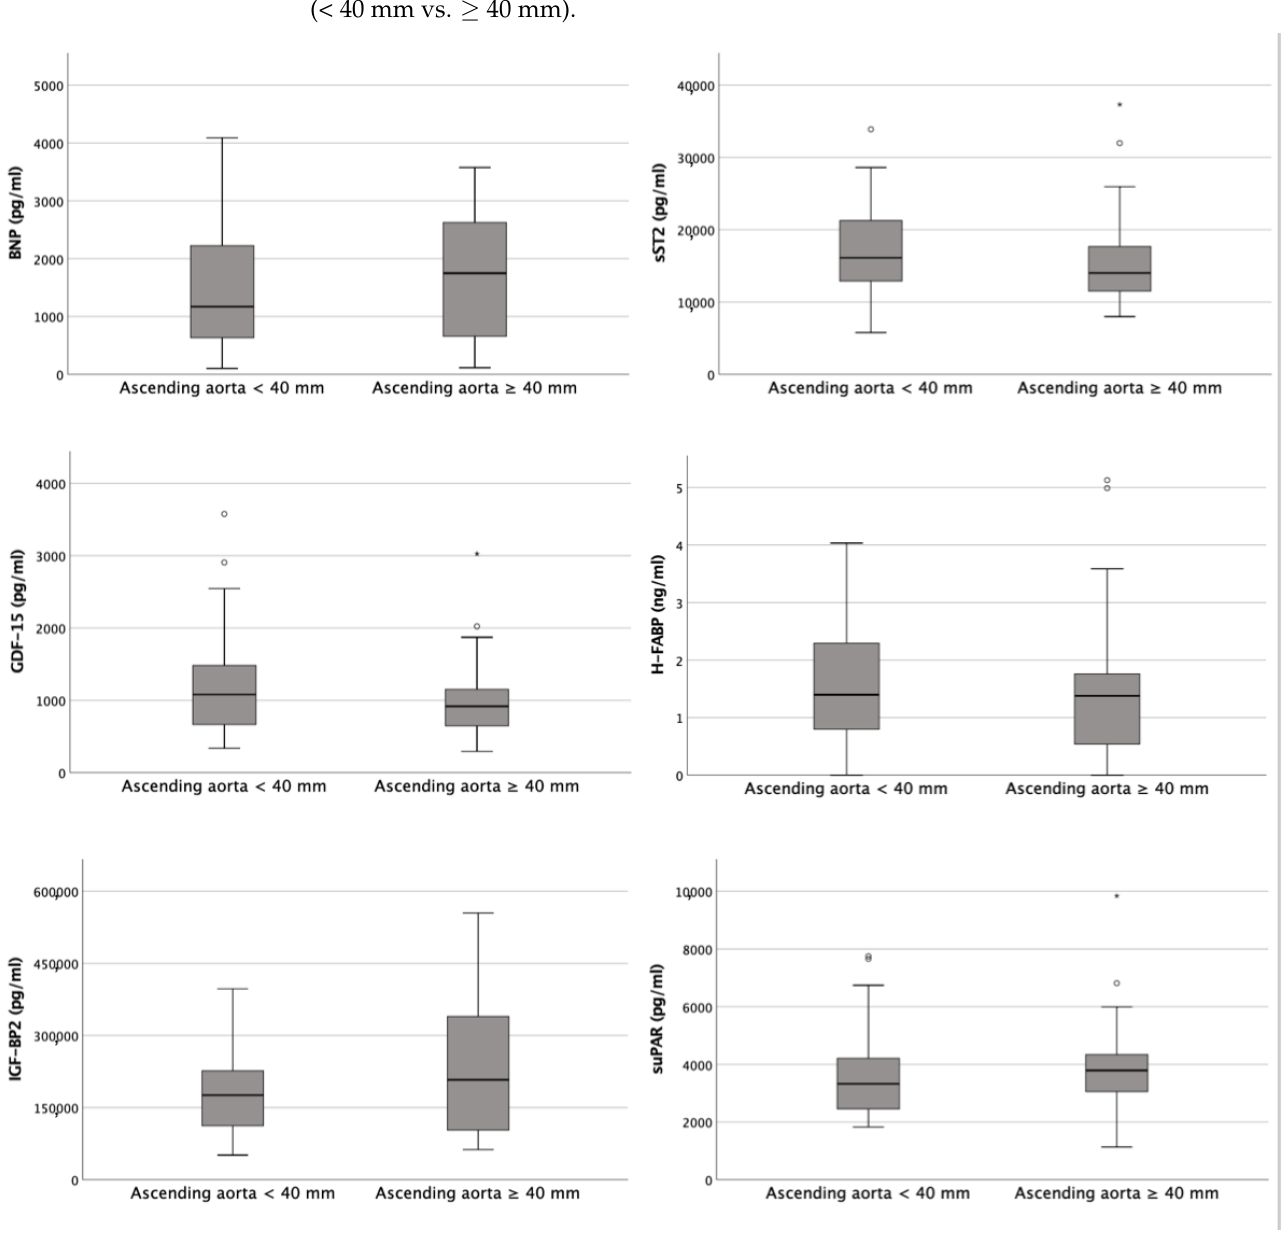
Figure 3. An overview of the corresponding plasma concentrations of the determined cardiovascular biomarkers depending on the diameter of the AA obtained (<40 mm vs. ≥40